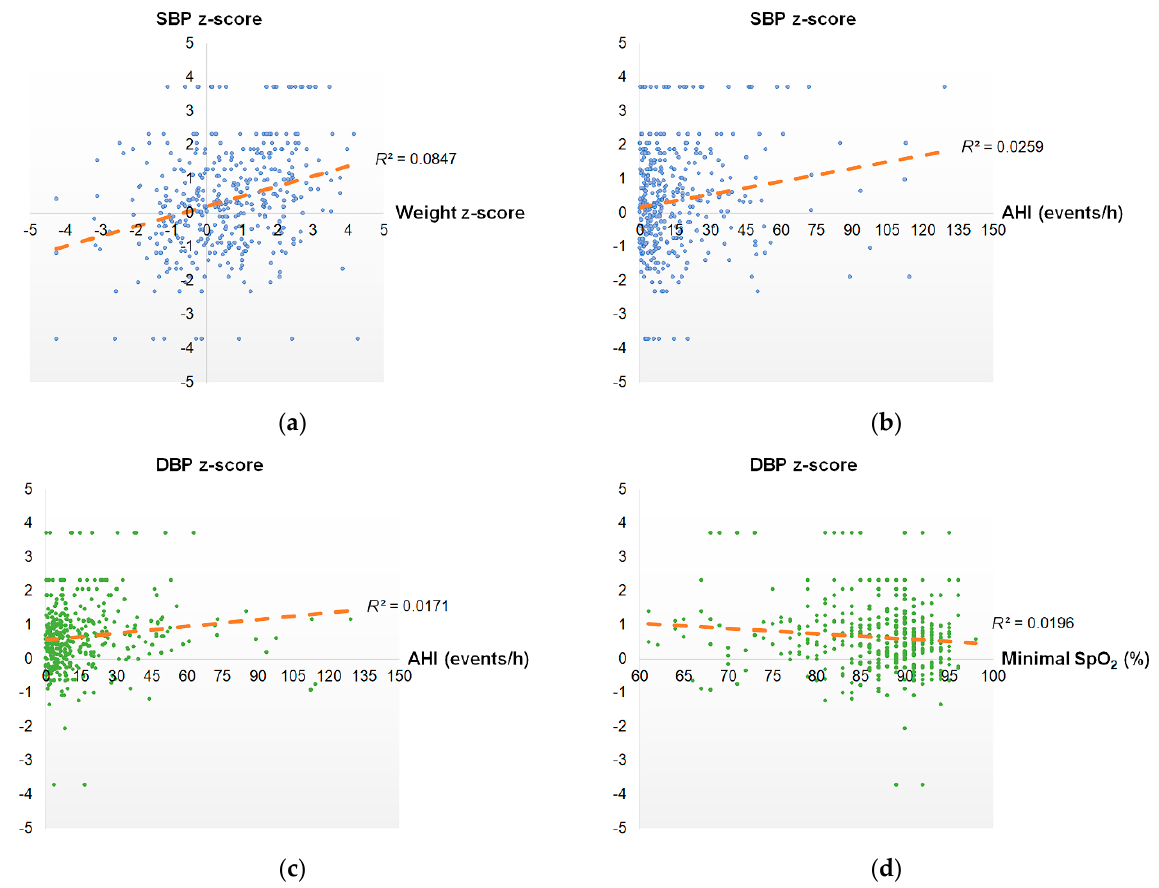
Figure 3. Correlation charts demonstrate the relationships between blood pressure and selected clinical variables. ( a ) Systolic blood pressure z-score versus weight z-score; ( b ) Systolic blood pressure z-score versus apnea-hypopnea index; ( c ) Diastolic blood pressure z-score versus apnea-hypopnea index; ( d ) Diastolic blood pressure z-score versus minimal oxygen saturation. The data are analyzed using Pearson correlation test. Abbreviations: AHI: apnea-hypopnea index; DBP: diastolic blood pressure; SpO 2 : oxygen saturation; SBP: systolic blood pressure. Table 2. Regression models of systolic and diastolic blood pressure in the overall